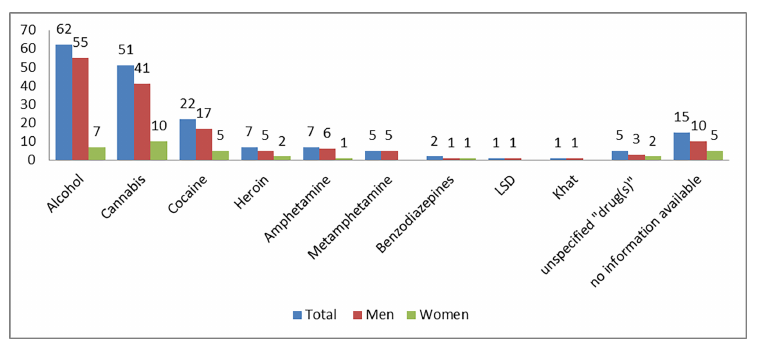
Fig 1. Reported substance use (count of